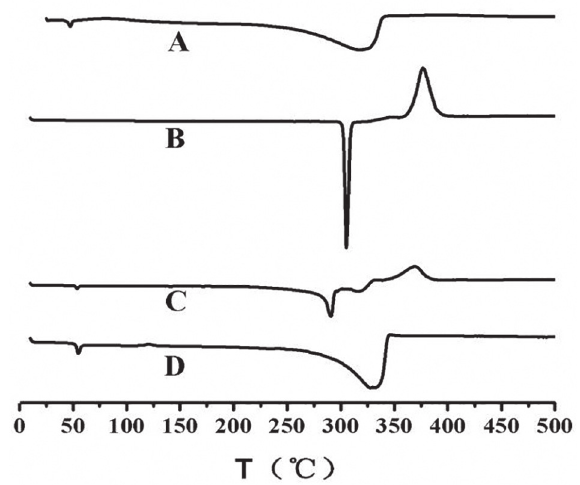
FIGURE 5 - The results of DSC of PLGA microspheres:(A) blank microspheres; (B) tadalafil; (C) mixture; (D) tadalafil loaded microspheres).